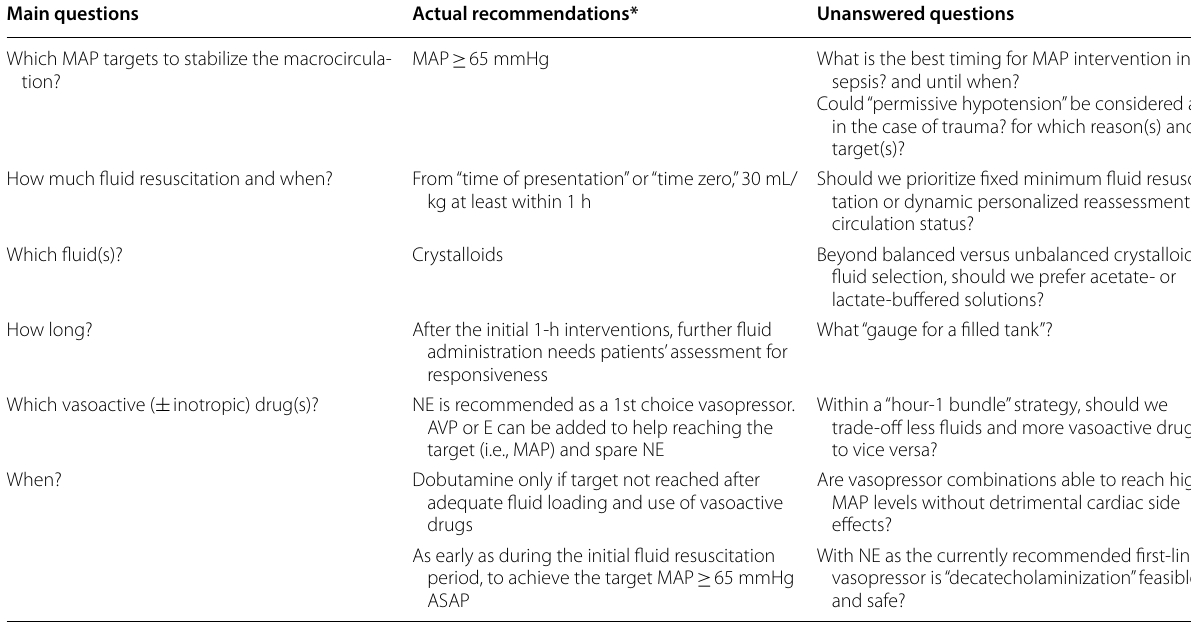
Table 4 Hemodynamics in early septic